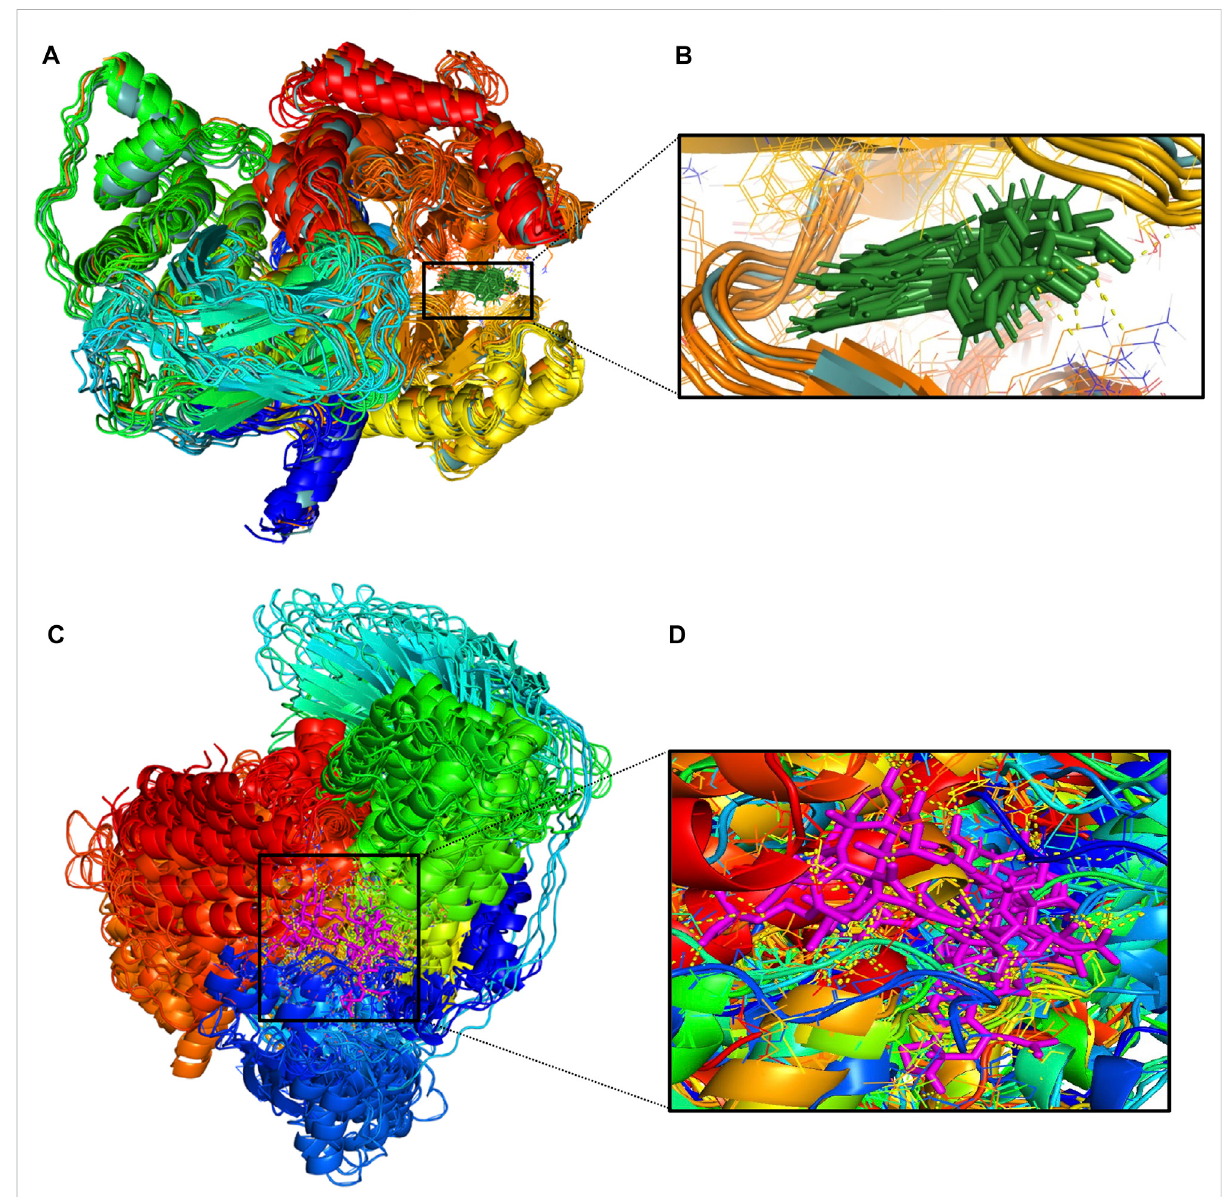
FIGURE 12 (A) -Conformational changes in 1E7U- 1J (protein-ligand) complex; (B) -(green color for ligand) (C) -Conformational changes in 1E7U- Wortmannin (protein-ligand) (D) -(pink color for ligand) interacting with with target protien in the active site extracted from molecular dynamics trajectory at different time interims to depict the complex stability. MM-PBSA based Binding free energy Calculations.